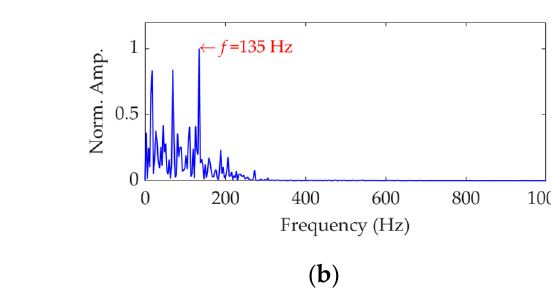
20 of 23 Figure 25. The EP index value of each mode. ( a ) ( b ) Figure 26. The optimal target mode: ( a ) time − domain waveform and ( b ) SES. Lastly, the vibration dataset of this case was also decomposed by the VMD method for comparison. The balancing parameter α of VMD was set as the optimal value of 2700 used in the SVMD method. The number of modes was set as 20, which is an optimal value determined by multiple experiments. In the results obtained by VMD, the target mode was the 18th mode, whose waveform and SES are shown in Figure 27. It can be seen that, as long as the parameters are set properly, VMD is also able to extract the FCF of the rolling bearing ball from the vibration dataset. However, it is important to note that, in a practical application, the two key parameters of VMD are not easy to deter-